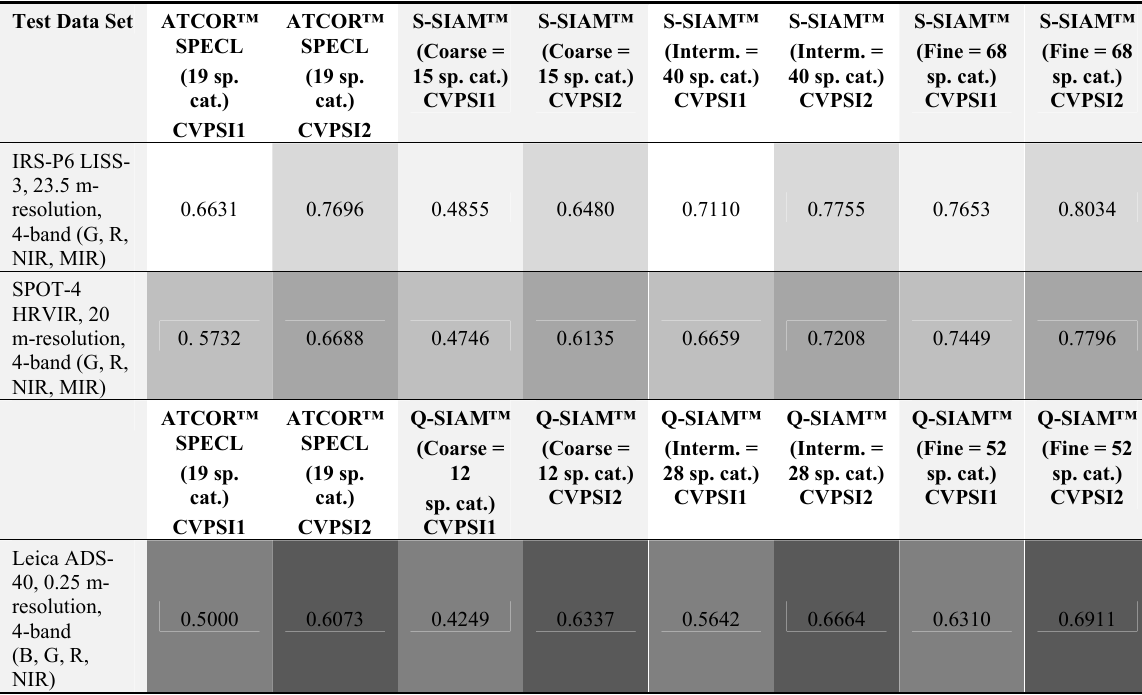
Table 14. CVPSI2 ≥ CVPSI1 ∈ [0, 1] values collected from the proposed 12 thematic maps, refer to Equation (A3) to (A10) in the